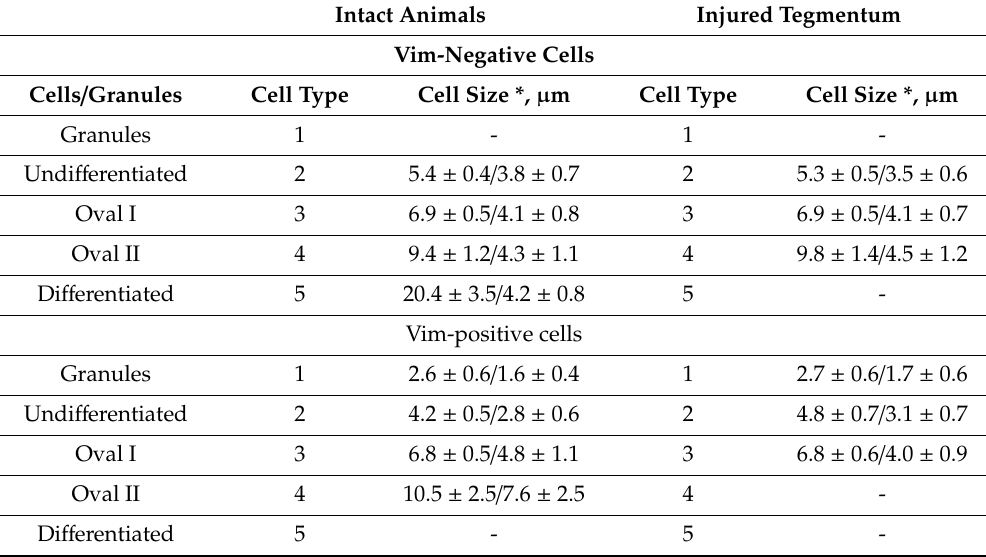
Table 3. Morphometric characteristics of vimentin-labeled cells (M ± SD) in the intact and